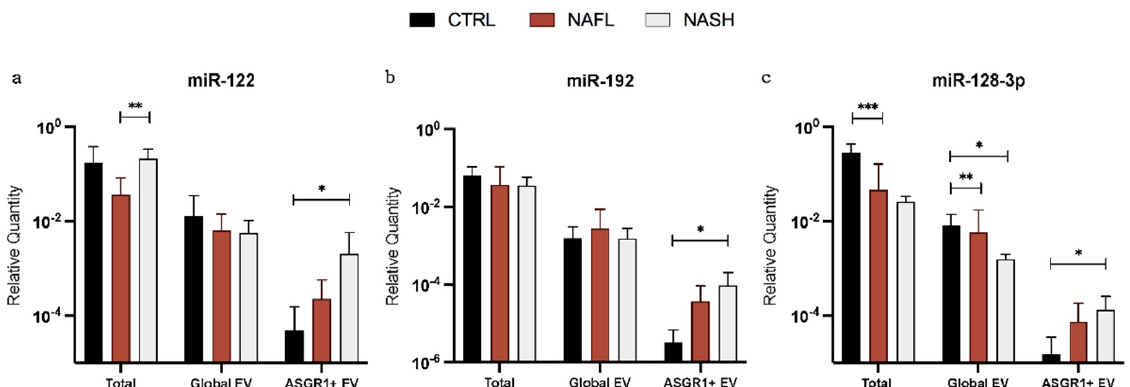
Figure 3. Differential expression of miRNA biomarkers in NAFLD. Relative quantities of miR-122 ( a ), miR-192 ( b ), and miR-128-3p ( c ) normalised to cel-miR-54 in total circulating RNA, global EVs, and asialoglycoprotein receptor 1 (ASGR1) positive EVs isolated from patients with NAFL and NASH and from controls. Statistical analysis performed by the Kruskal-Wallis test with Dunn’s for multiple comparisons. * p ≤ 0.05, ** p ≤ 0.01, *** p ≤ 0.001. Error bars represent standard deviation.